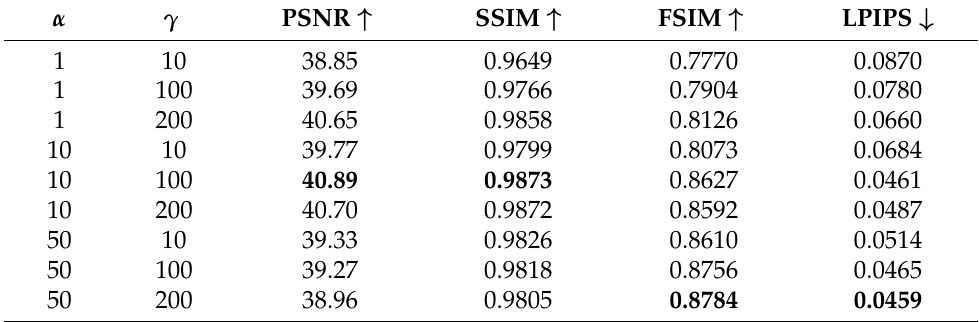
Figure 8. ( a ) PSNR versus number of training iterations for ablation study. ( b ) Value of ω ( t ) versus number of training iterations. Table 8. Influence of α and γ in Equation (5) on the Levin test set [33]. The best results are